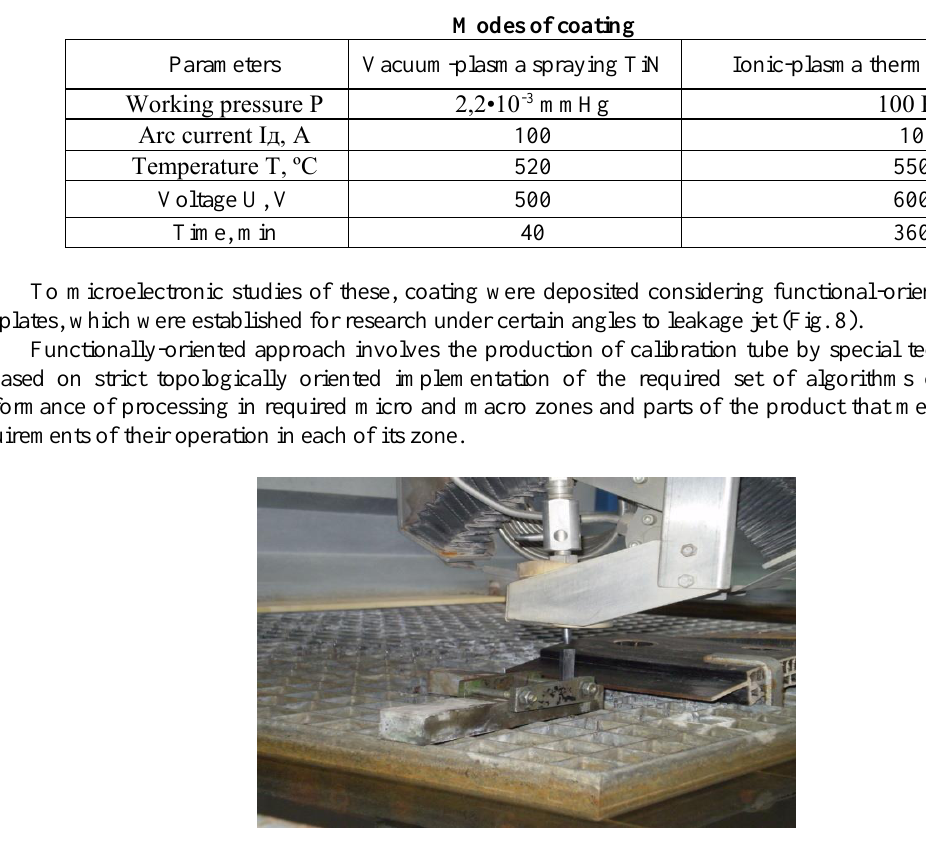
Fig. 8. Installation of a test piece on desktop of hydrocutting machine